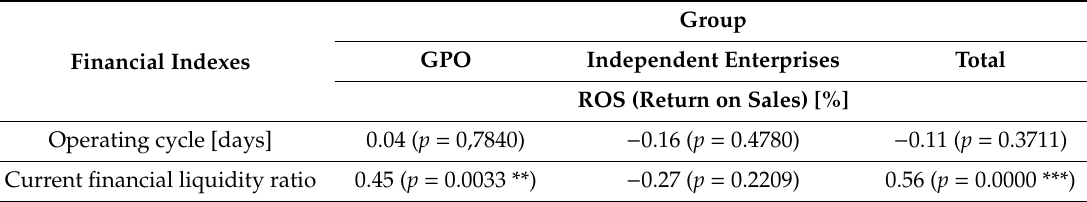
Table 4. An analysis of the relationship between liquidity, efficiency and profitability in the surveyed enterprises.